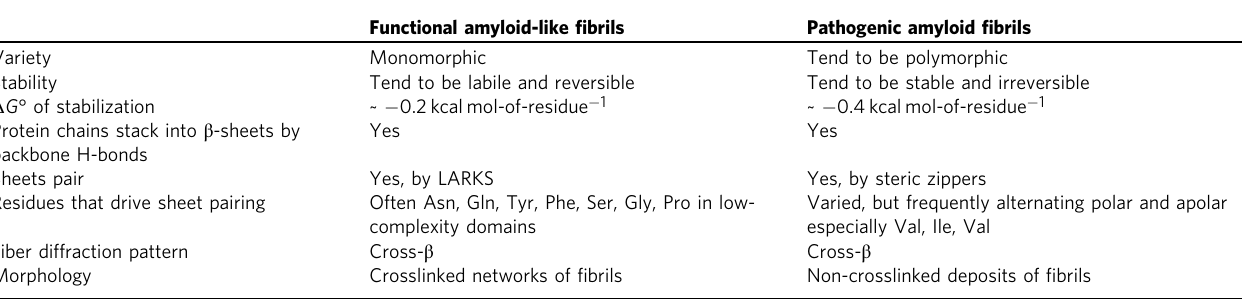
Table 4 Comparative properties of functional amyloid-like fi brils and pathogenic amyloid fi